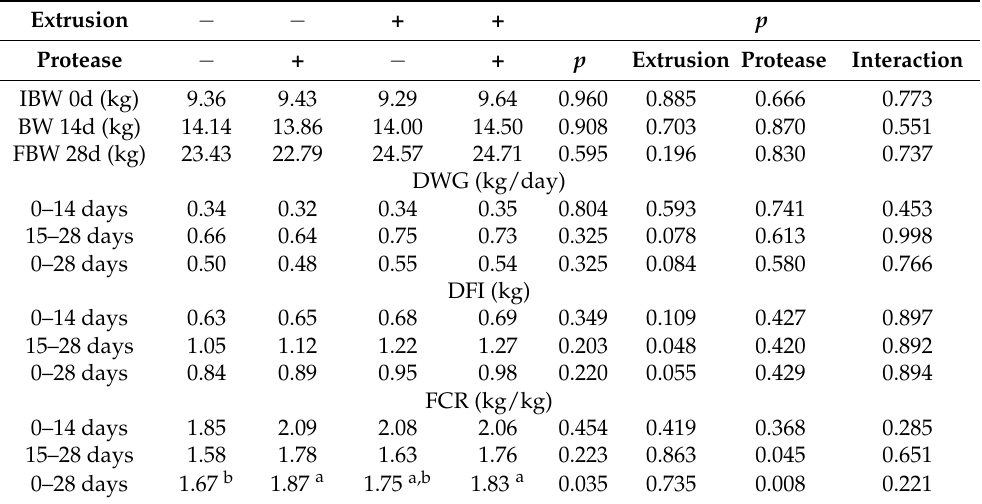
Table 3. Body weight, body weight gain, daily weight gain, daily feed intake, and feed utilisation of pigs ( n =